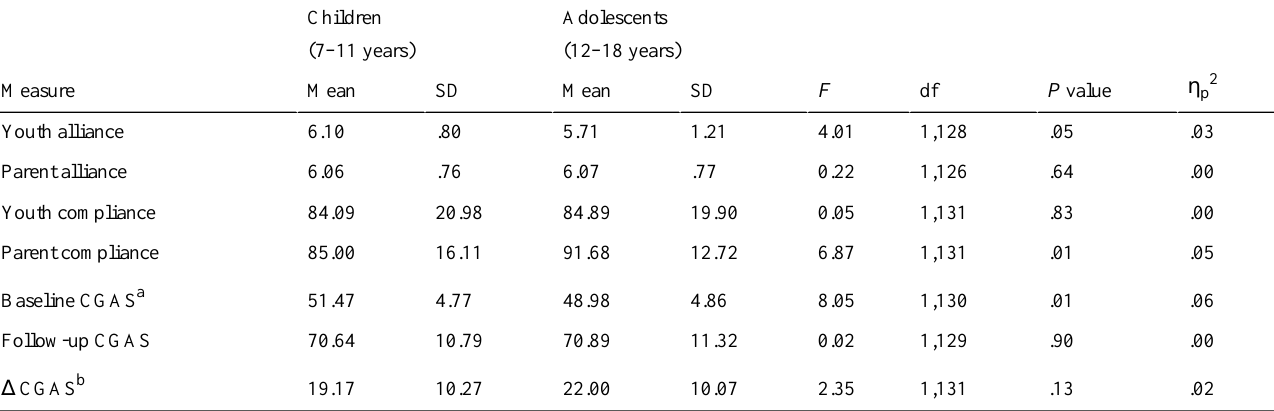
Table 3. Means, standard deviations, and regression analyses for alliance, compliance, and CGAS scores compared between children and